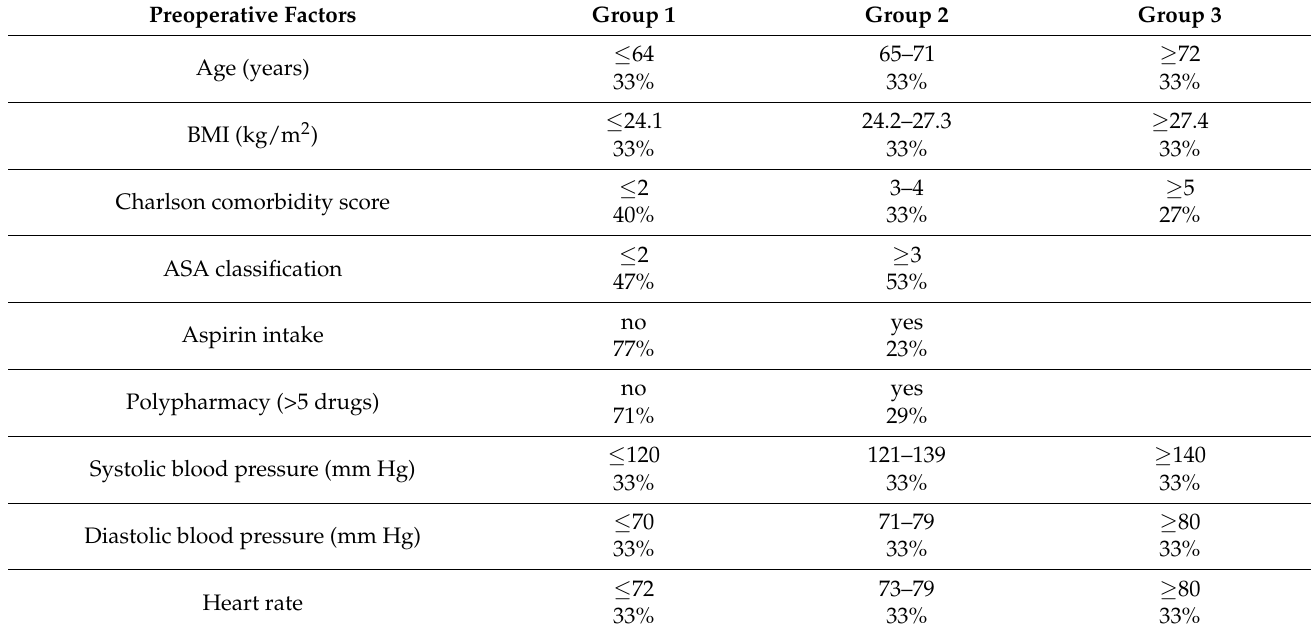
Table A1. Patients who underwent radical cystectomy were distributed into three groups according to preoperative patient characteristics, vital signs and blood